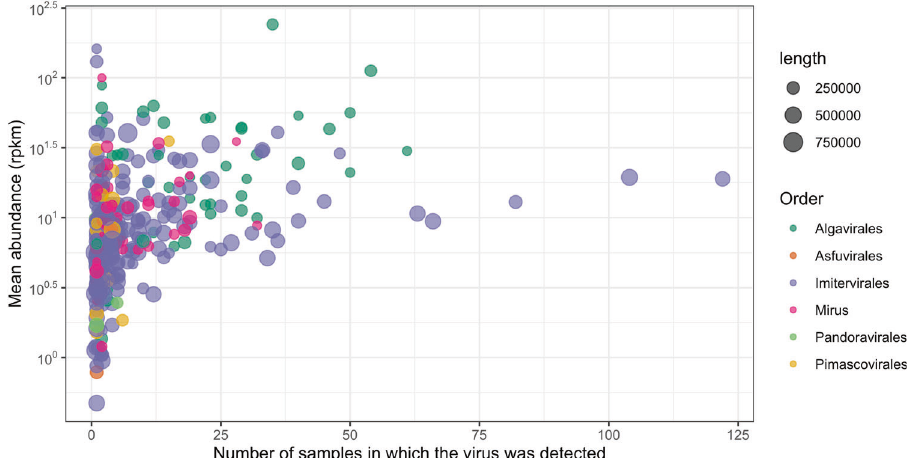
Fig. 4 General mapping statistics of viruses found in surface waters <150 m. The y-axis shows the average abundance of a given individual genome (in RPKM), and the x-axis shows the number of samples from which the virus was recovered. Dots are colored by the viral order and dot sizes represent the length of the genomes. suggesting that diatoms are potential hosts of this viral lineage. The only Algavirales virus belonged to the Prasinoviridae family ( Algavirales family 1). The most broadly distributed genome, ERX556088.18.dc, a Mesomimivirus (Imitervirales family 1), was recovered in 122 samples (more than 25% of the total number of samples analyzed overall) at 34 sampling locations. All the fi ve